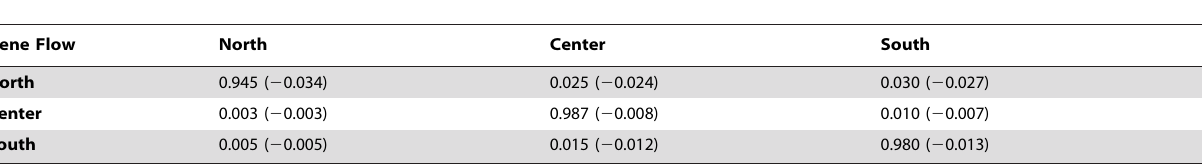
Table 4. Matrix of inferred gene flow between genetic clusters.